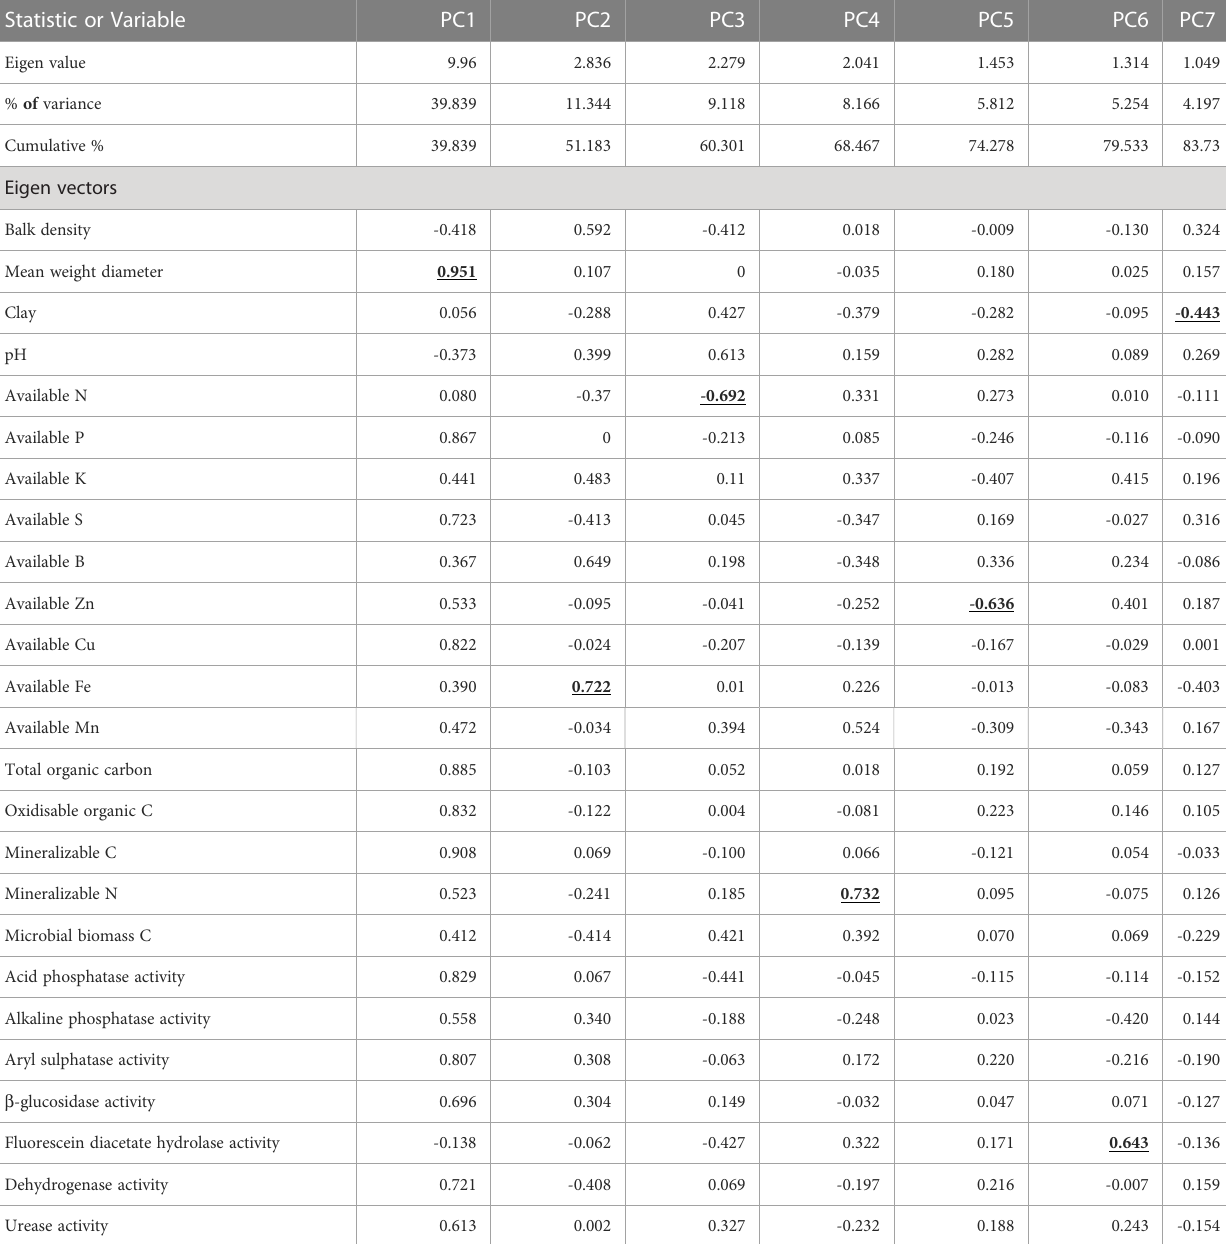
TABLE 5 Principal components with factor loading of soil